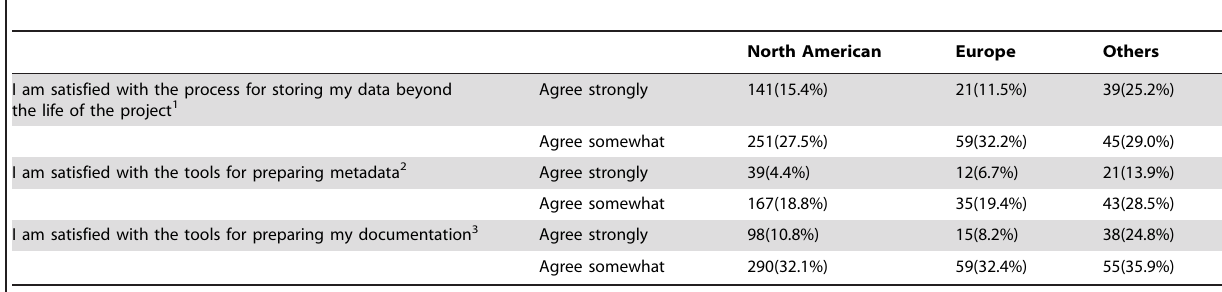
Table 32. Satisfaction with data management by geographic